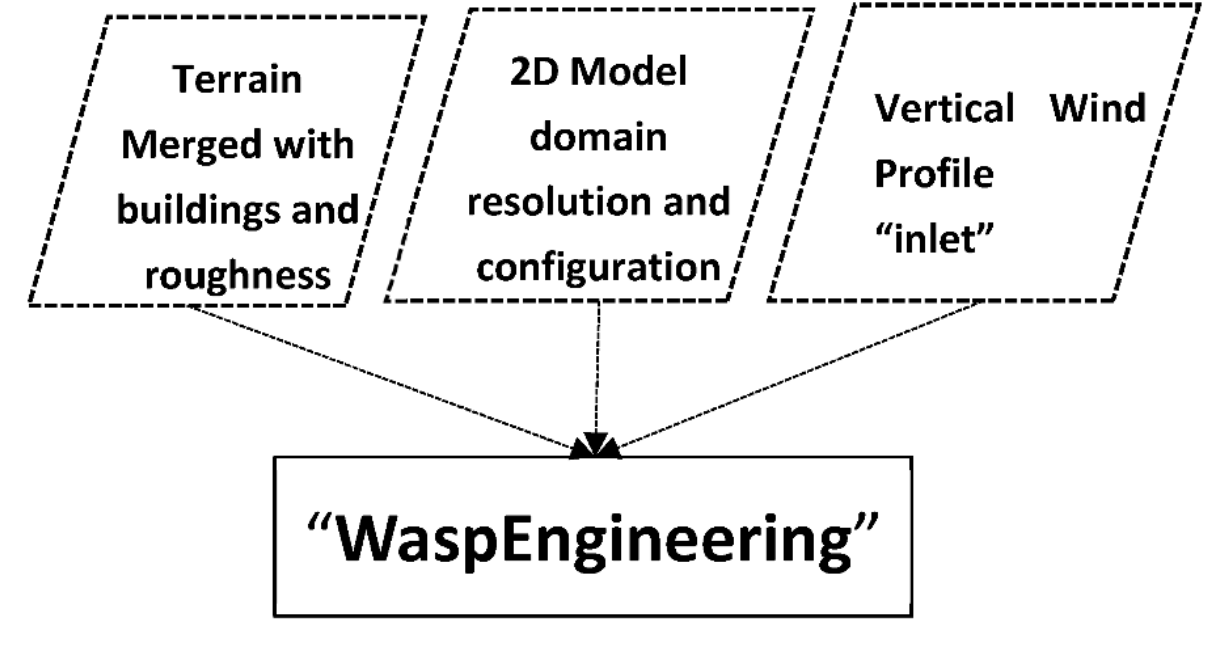
Figure 6. Schematic workflow for performing a simulation with WAsP Engineering.